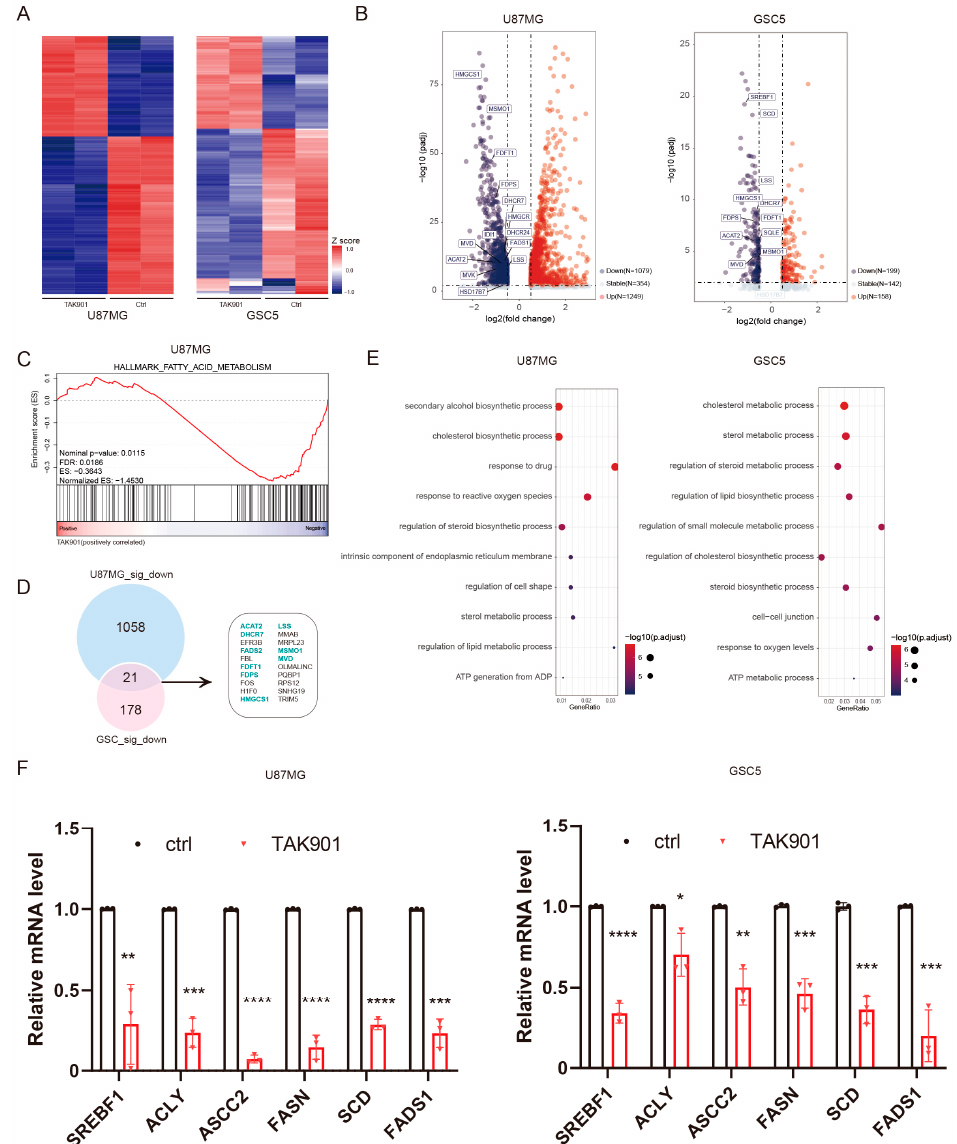
Figure 4. TAK901 suppresses the expression of genes related to lipid metabolism. U87MG cells were treated with 0.2 μ M TAK901 or vehicle for 72 h. GSC5 cells were treated with 0.1 μ M TAK901 or vehicle for 72 h. The cells were subjected to transcriptomic analysis. n = 2. ( A ) Heatmaps showing the robustness of the RNA-seq data for U87MG (left) and GSC5 (right) cells. Plot showing the top 200 commonly regulated (padj < 0.05 and log2FC ≤ − 0.5 or log2FC ≥ 0.5) genes of U87MG and GSC5 cells. ( B ) Volcano plot of the expression of genes in TAK901-treated U87MG (left) and GSC5 (right) cells. Plot showing the commonly regulated (padj < 0.05 and log2FC ≤ − 0.5 or log2FC ≥ 0.5) genes of U87MG and GSC5 cells. Red: significantly upregulated genes; blue: significantly downregulated genes, gray: non-affected genes. Some genes related to the lipid metabolism pathway are labeled. FC: fold change. ( C ) Gene set enrichment analysis (GSEA) plot depicted the DEGs identified between control and TAK901 treated group in U87MG. Fatty acids metabolism is shown. ( D ) Overlap gene set of significantly downregulated (padj < 0.05 and log2FC ≤ − 0.5) genes of U87MG ( up ) and GSC5 ( down ). Lipid metabolism-related genes are highlighted. ( E ) Gene Ontology enrichment analysis of downregulated genes in U87MG ( left ) and GSC5 ( right ) cells. Dots on the graph indicate enriched pathways. Most pathways are related to lipid metabolism. ( F ) U87MG cells were treated with 10 μ M TAK901 or vehicle for 72 h. GSC5 cells were treated with 1 μ M TAK901 or vehicle for 72 h. Expression of genes related to fatty acid metabolism in U87MG (left) and GSC5 (right) cells